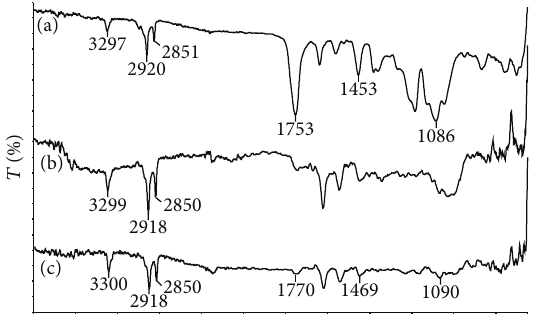
Figure 7: FTIR spectra for (a) poly(lactic acid), (b) cellulose, and (c)